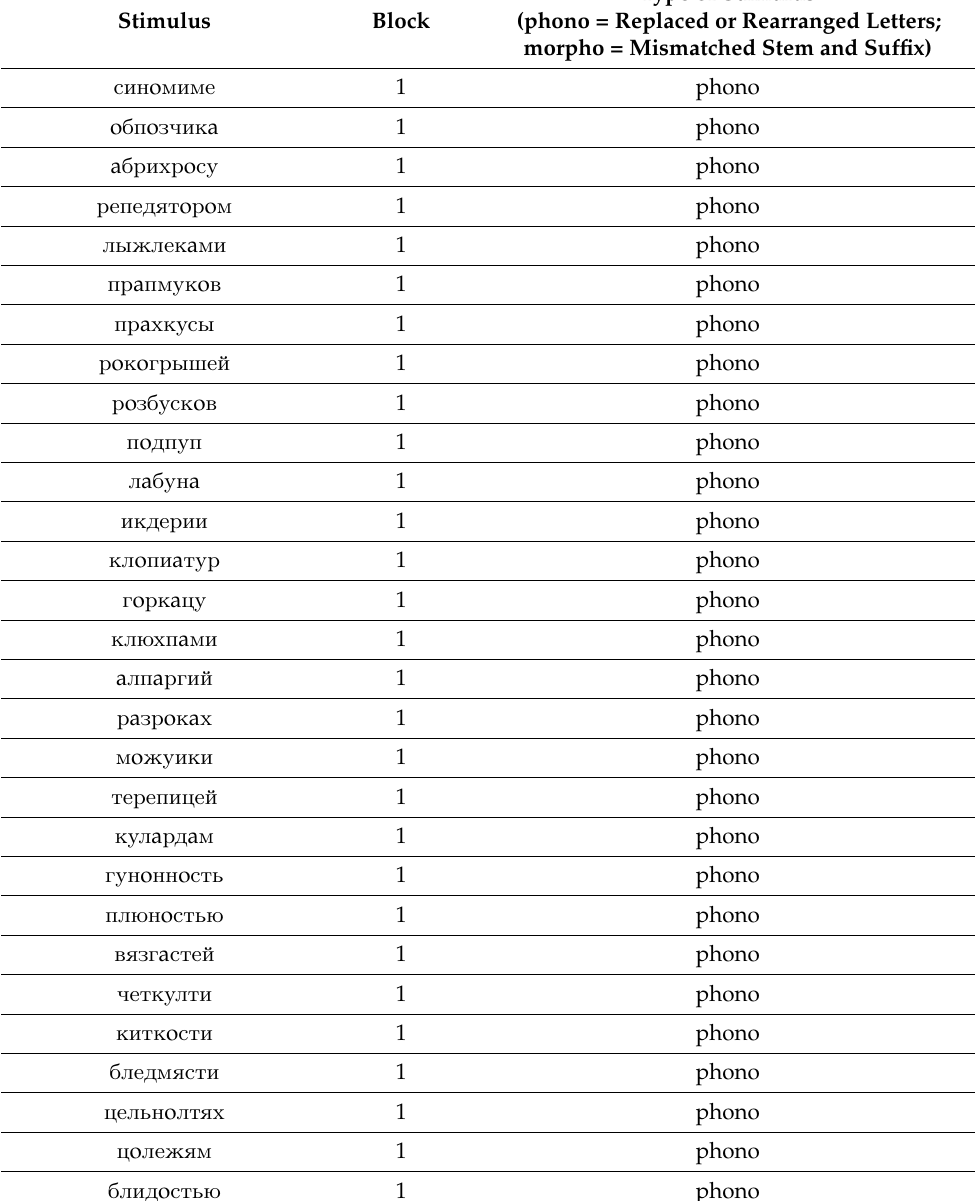
Table A2. Non-word